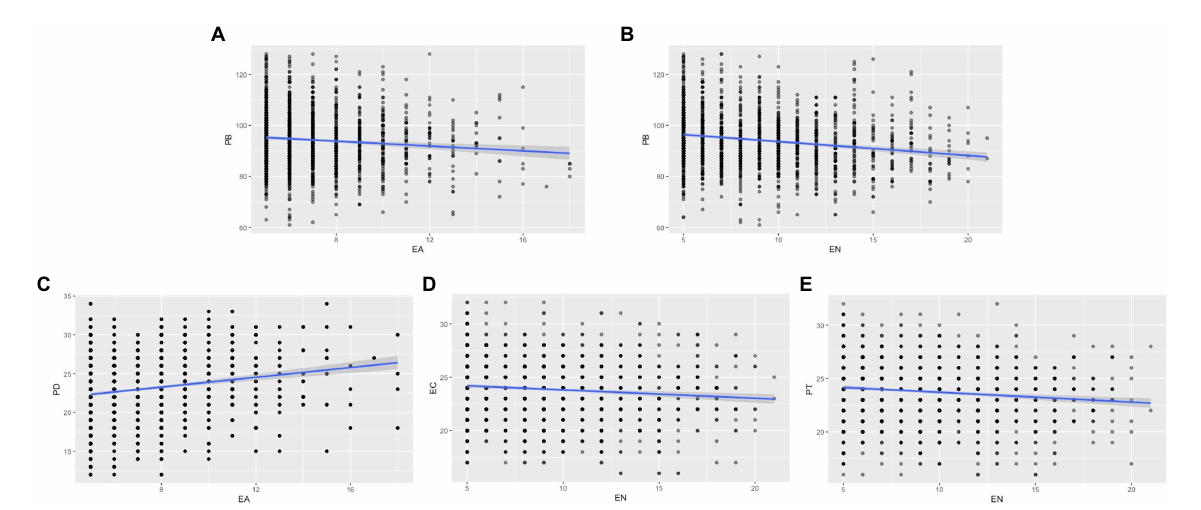
FIGURE 1 Scatterplots of the main correlations. EA, emotional abuse; EN, emotional neglect; PB, prosocial behavior; PD, personal distress; EC, empathic concern; PT, perspective-taking. (A) correlation between EA and PB; (B) correlation between EN and PB; (C) correlation between EA and PD; (D) correlation between EN and EC; (E) , correlation between EN and